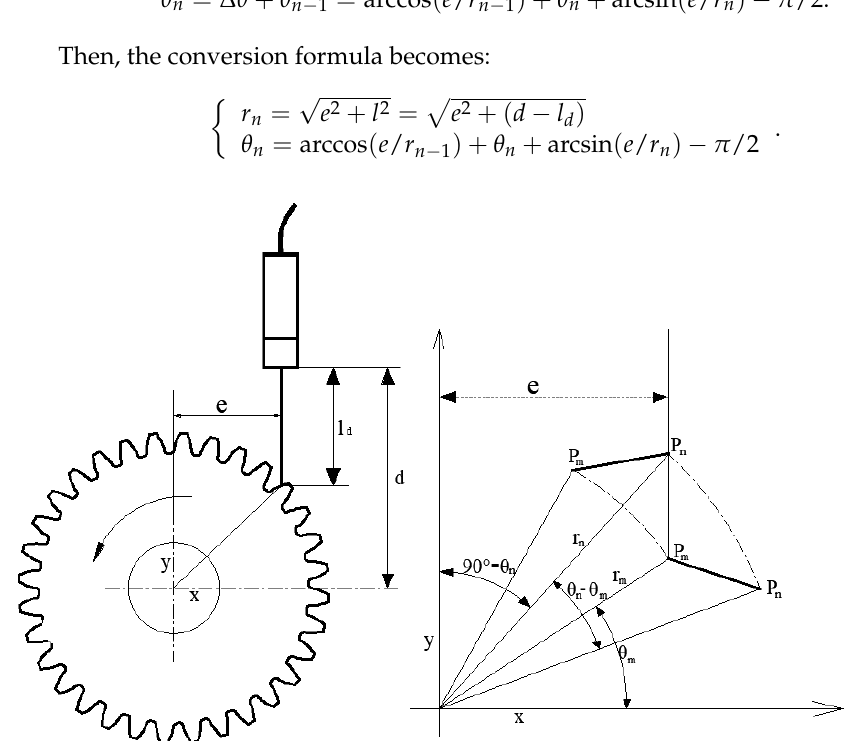
Figure 5. Schematic diagram of offset laser measurement method.